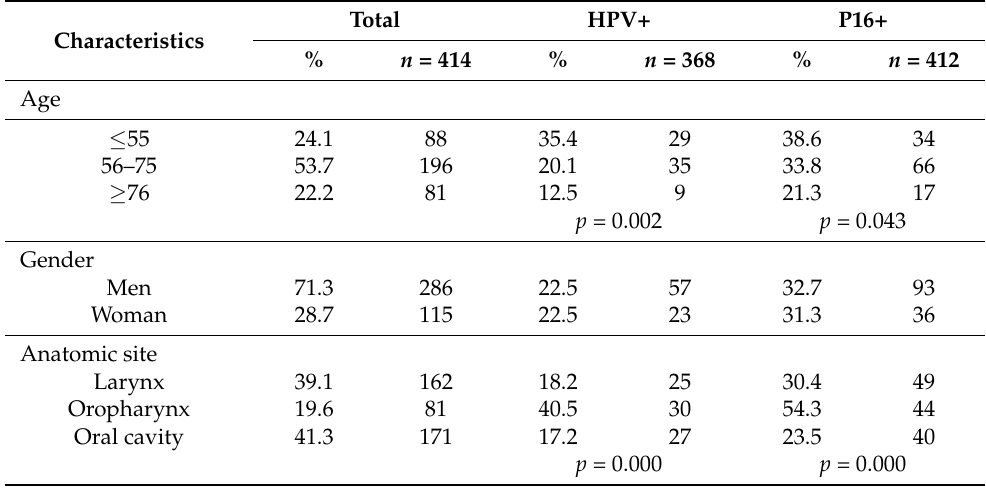
Table 1. Clinic characteristics of head and neck cancer patients, DNA HPV presence, and p16